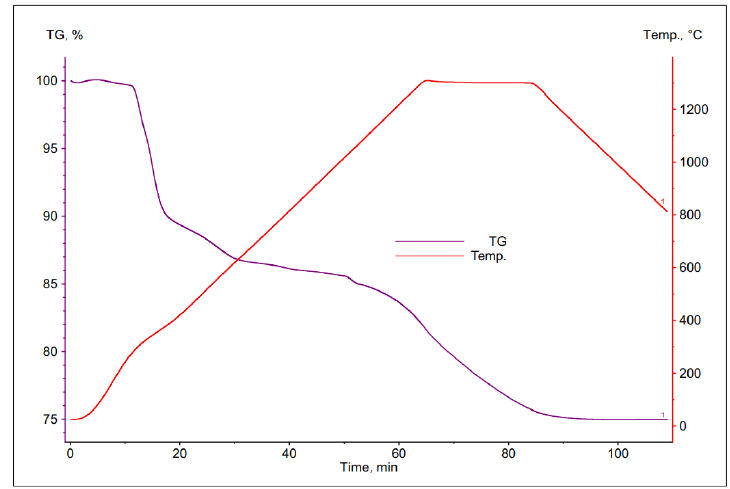
Figure 8. Change in mass of a sample with grain size 3.15 ÷ 6.3 mm during its heating.